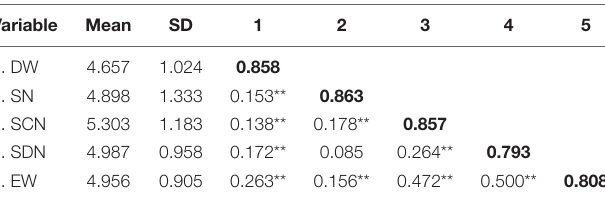
TABLE 3 | Correlation coefficient matrix and discriminant